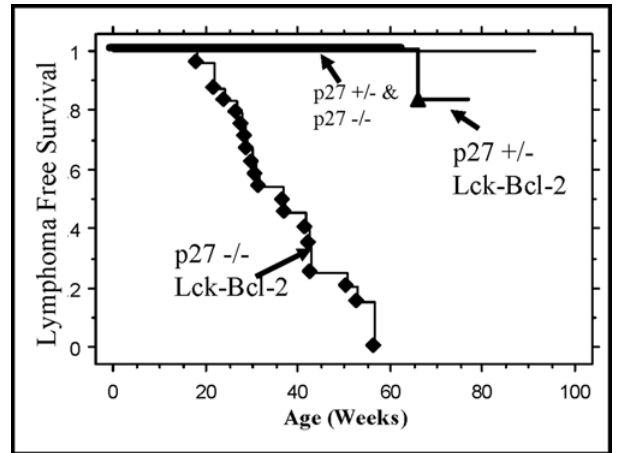
Figure 7. Bcl-2 synergizes with p27 deficiency to rapidly promote lymphoma formation. Mice of the indicated genotype were followed for thymic tumor free survival as described in the Materials and Methods. Kaplan-Meier lymphoma free survival analysis of mice of the indicated genotypes is shown. Lymphoma formation in p27 2 / 2 Lck-Bcl-2 mice was significantly (P , 0.01) accelerated compared to